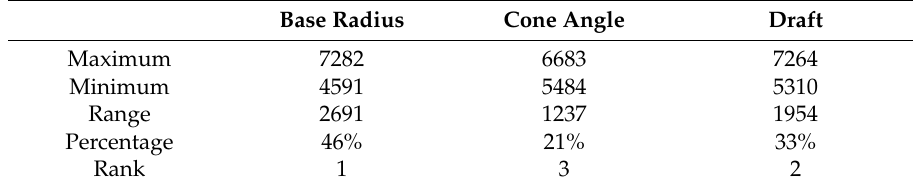
Table 5. Influence degree of geometric parameters on energy absorption efficiency.